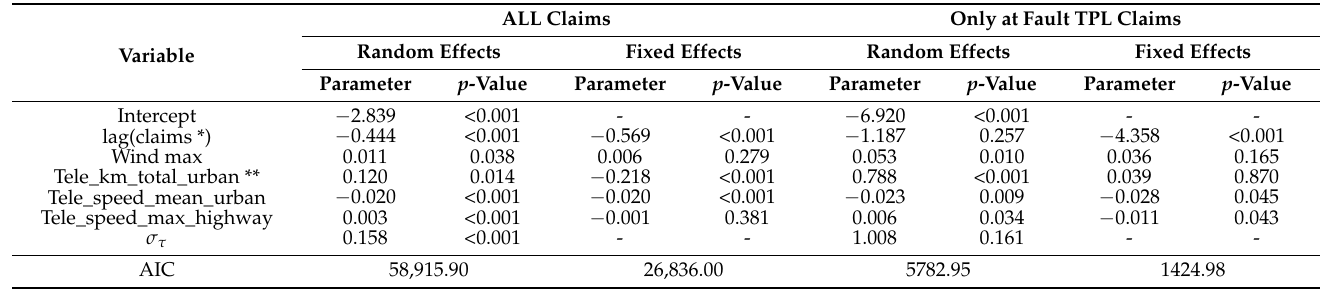
Table A4. Cross-table with the parameter estimates of random effects and fixed-effects Poisson panel data models, with p -values. for the total number of claims (left) and at-fault third party liability (TPL) claims (right) per month and per insured based on the seven observed months in 2018 and 2019. Monthly maximum daily average wind speed is introduced as the weather-related